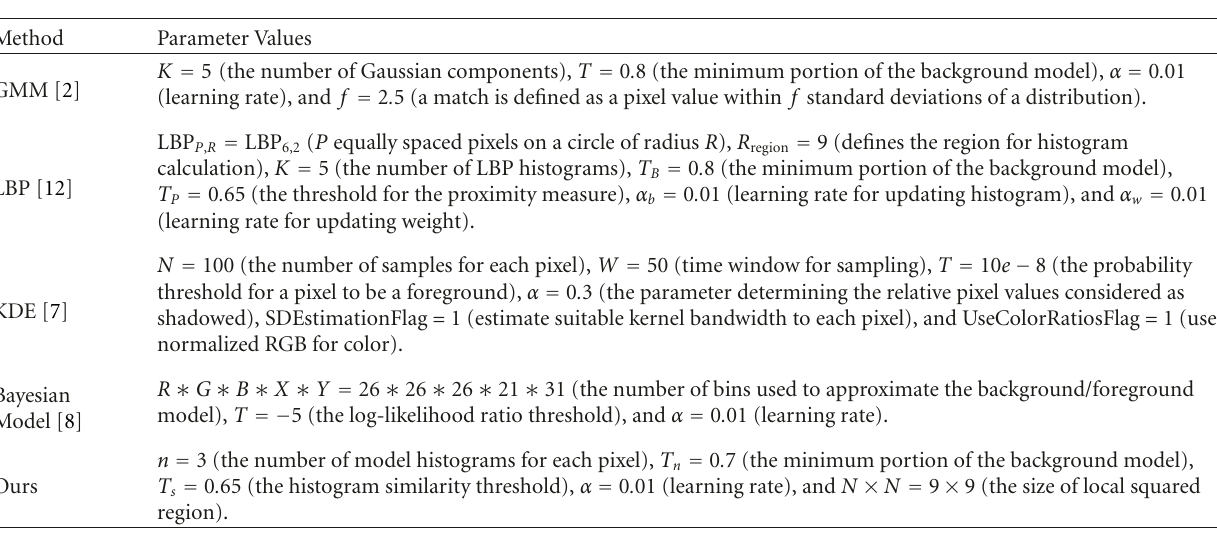
Table 1: The parameter values of the five BGS